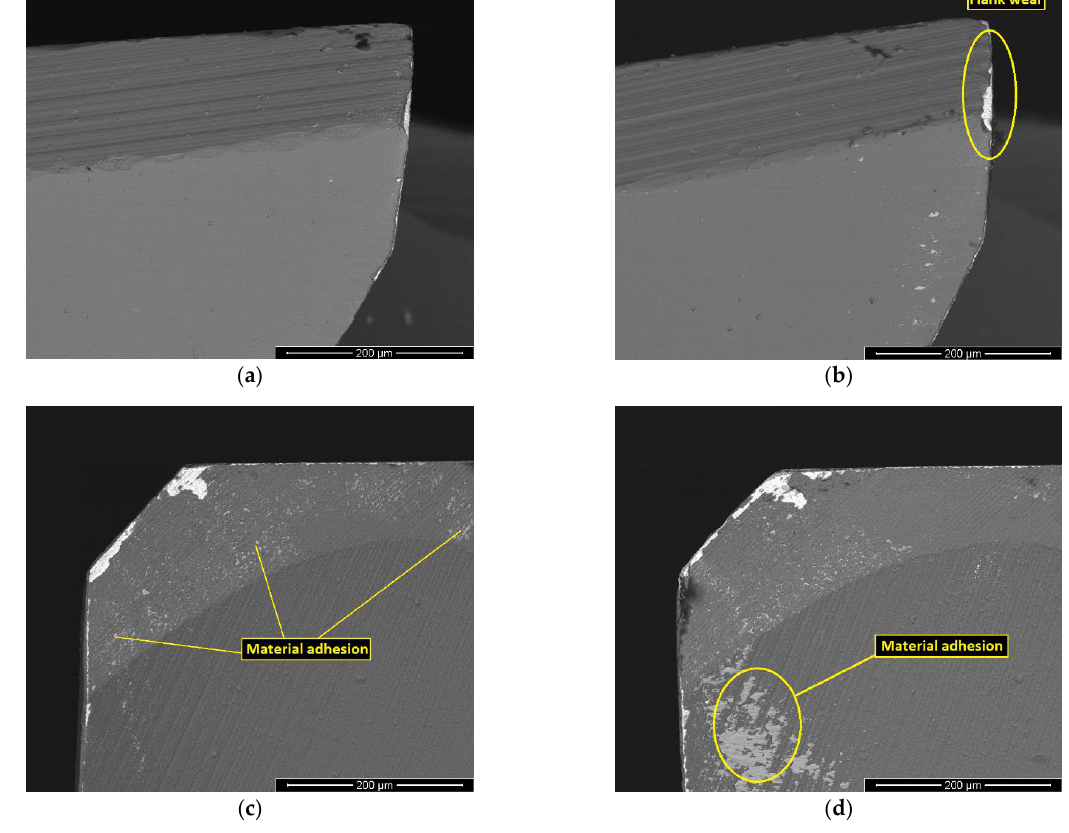
Figure 4. Clearance face, with a 500× magnification, of the T1L2F100 ( a ) and T1L4F100 ( b ) tools, and rake face, with a 500× magnification, of the T1L2F100 ( c ) and T1L4F100 ( d ) tools.